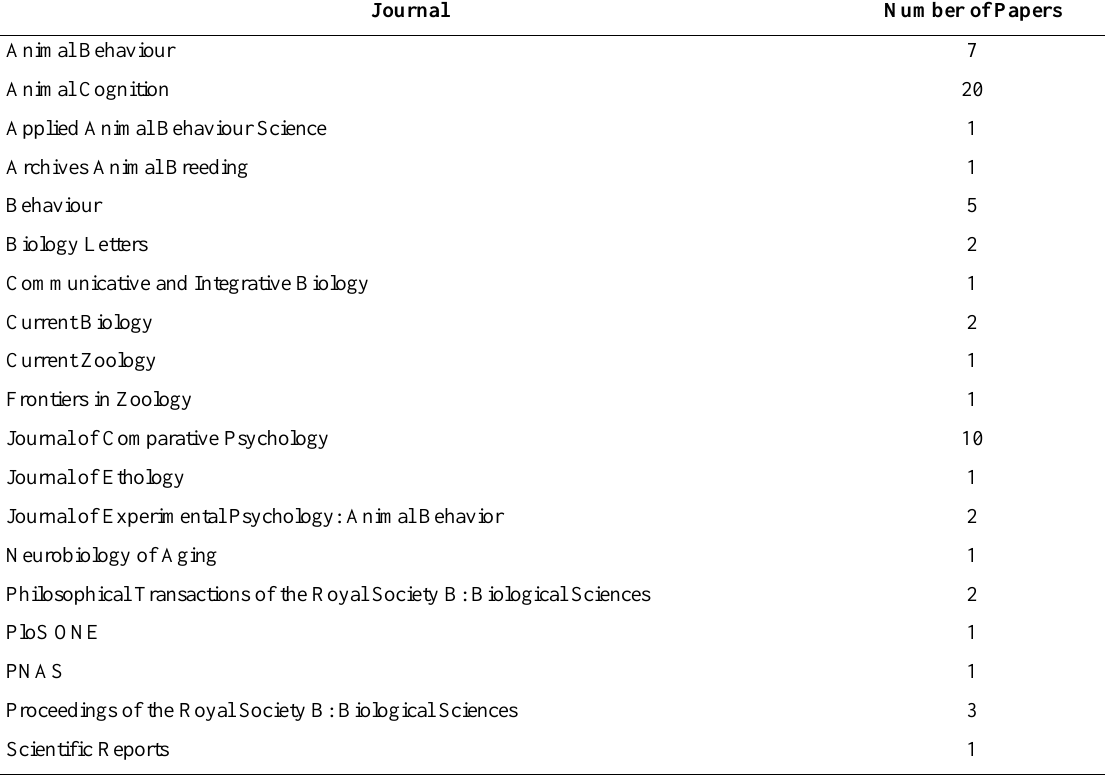
The Journals in which Our Sample of Physical Cognition Papers Were Published